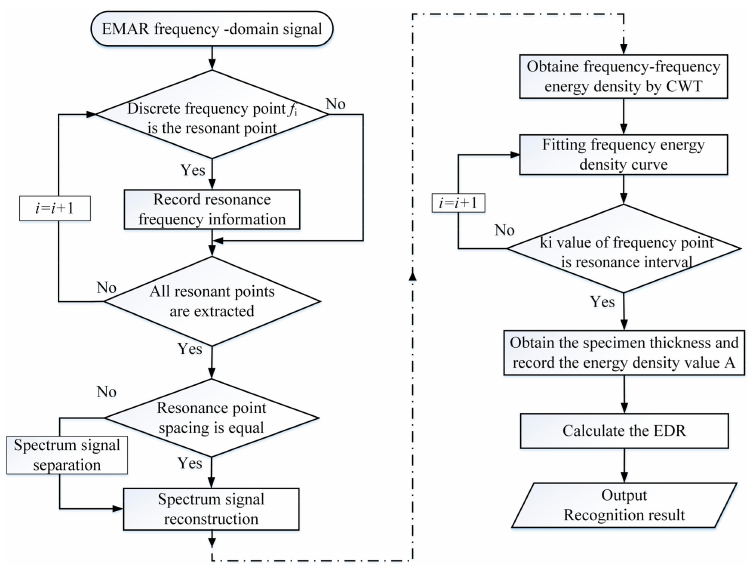
Figure 2. EMAR step surface information separation and recognition method based on FFEDP.